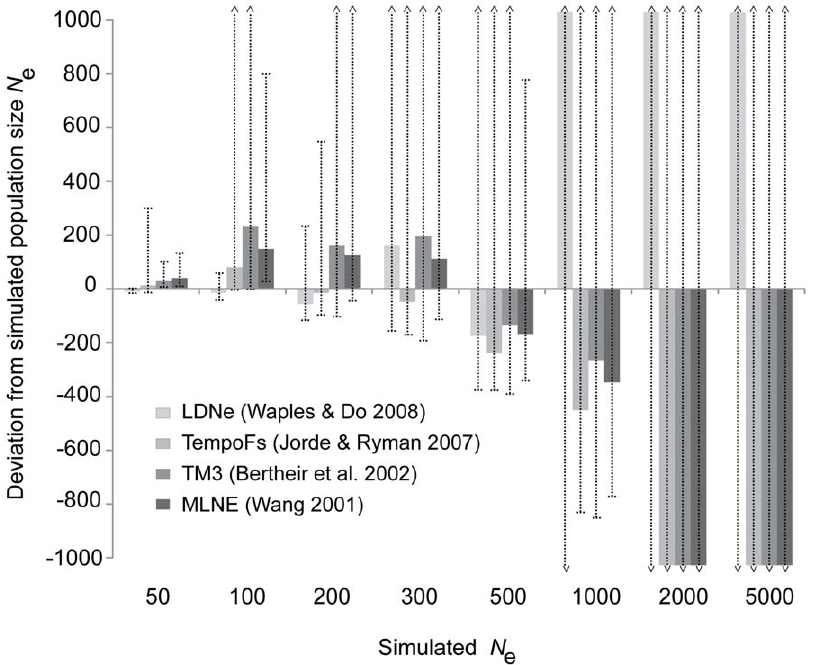
Figure 3. Estimates of N e from simulated populations of known size. Three different temporal methods (TempoFs, TM3, MLNE) and a fourth method (LDNe) based on a single time period were used to estimate N e . Similar to our empirical data from Padre Island, TX, temporal estimates were based on seven generations ( T 0 - T 7 ), while the single time period estimate is from the simulated 7 th generation (see methods). Bars represent deviated estimates of N e from simulated population size and the dotted vertical lines reflect 95% confidence intervals. ˆ = values beyond the range of y-axis (see also Table 3 for point estimates used in this figure).